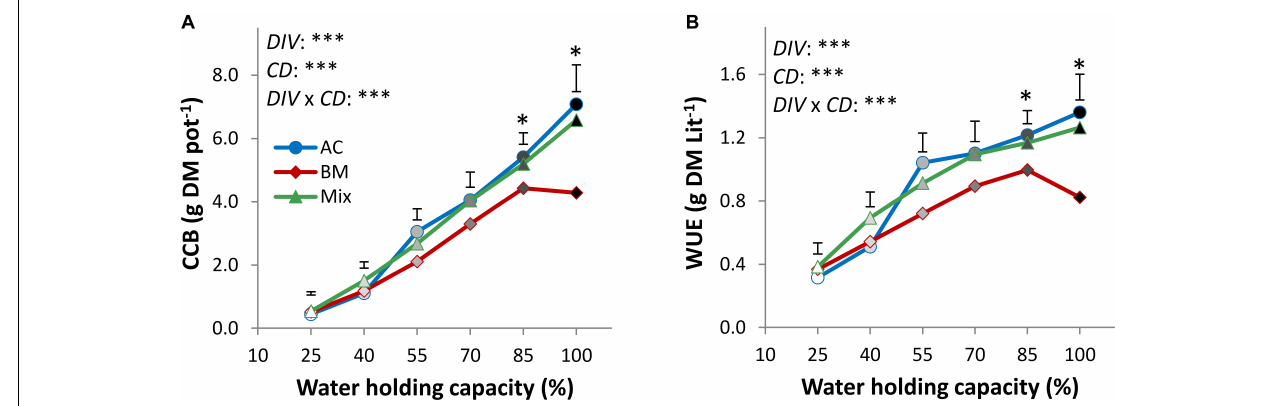
FIGURE 1 | Cover crop aboveground biomass (CCB, dry matter; A ) and water use efficiency (WUE; B ) of alsike clover (AC) and black medic (BM) in monocultures and a 1:1 mixture of the two species (Mix) in response to six intensities of cumulative drought (100, 85, 70, 55, 40, and 25% WHC) visualized in black gradient color. Vertical bars represent Tukey’s HSD test ( p < 0.05) at a given WHC (%) of n = 4. Asterisks above the vertical bars indicate significant differences among the mean of the monocultures and the mixture at each drought intensity (WHC; %) based on one-way ANOVA at P < 0.05. However, asterisks next to the factors DIV , CD , and DIV × CD indicate significant effects based on ANOVA results of the generalized linear model; ∗∗∗ P < 0.001, ∗ P < 0.05.